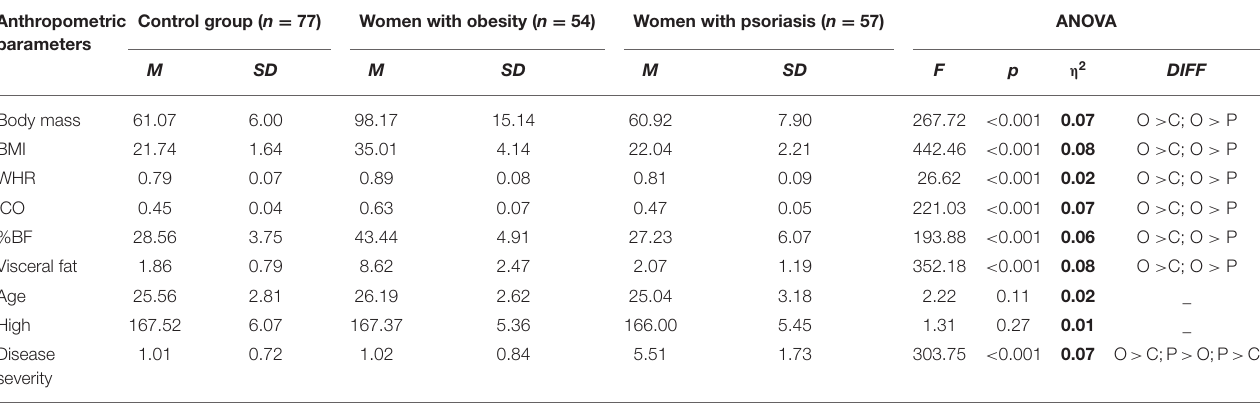
TABLE 1 | Anthropometric differences between the groups. Anthropometric